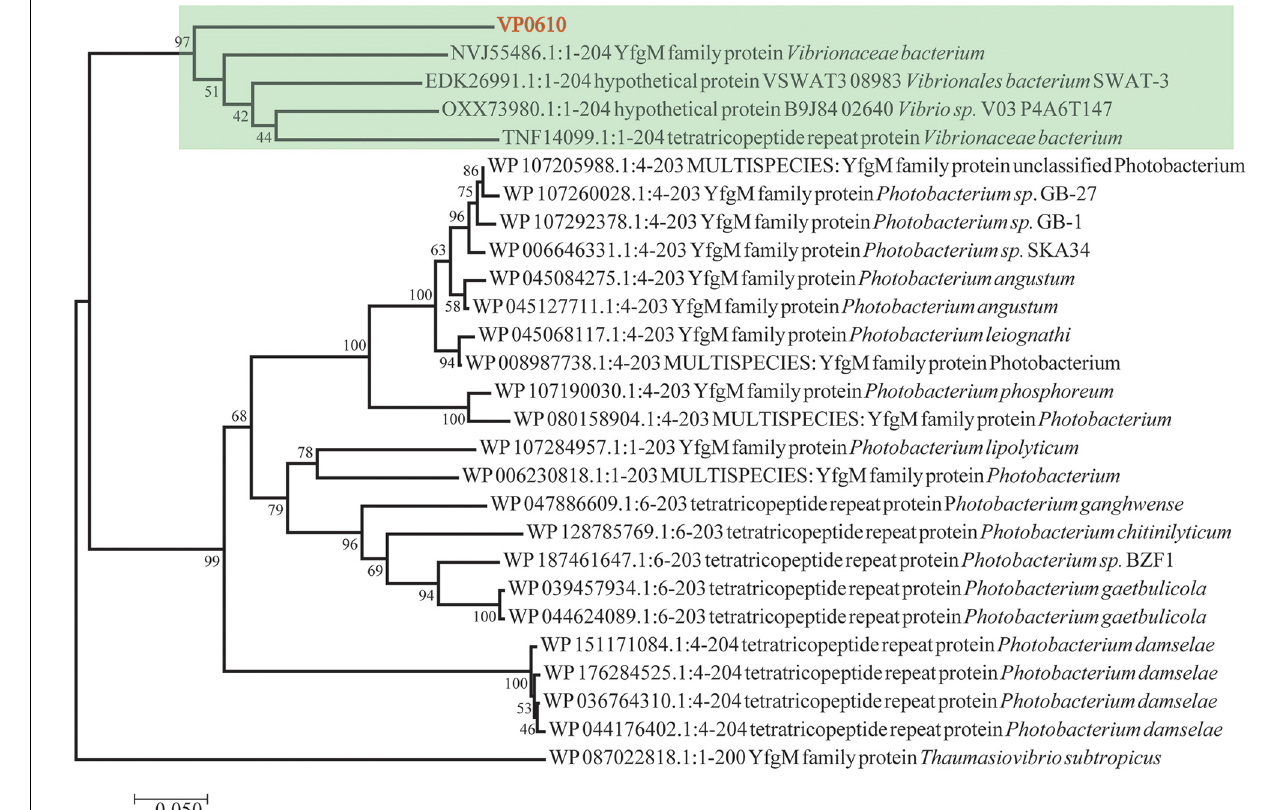
FIGURE 1 | Evolutionary relationships of vp0610 . The evolutionary history was inferred using the Neighbor-Joining method (Saitou and Nei, 1987). The optimal tree with the sum of branch length = 2.50135052 is shown. The percentage of replicate trees in which the associated taxa clustered together in the bootstrap test (1,000 replicates) are shown next to the branches (Felsenstein, 1985). The tree is drawn to scale, with branch lengths in the same units as those of the evolutionary distances used to infer the phylogenetic tree. The evolutionary distances were computed using the Poisson correction method (Zuckerkandl, 1965) and are in the units of the number of amino acid substitutions per site. The analysis involved 27 amino acid sequences. All positions containing gaps and missing data were eliminated. There was a total of 195 positions in the final dataset. Evolutionary analyses were conducted in MEGA7 (Sudhir et al.,